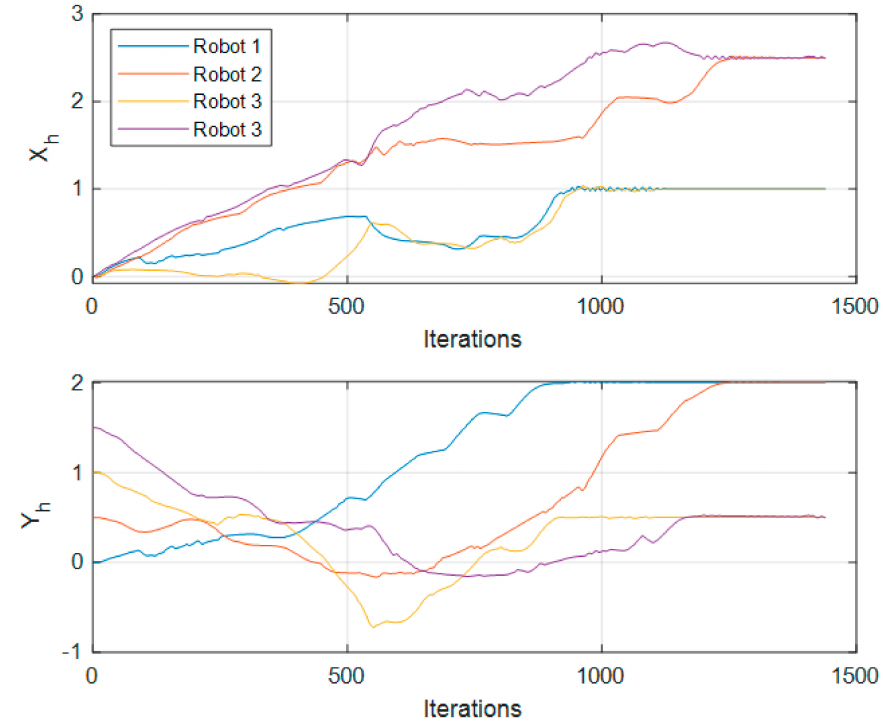
Figure 17. Trajectories along iterations in the 4-robot real-world